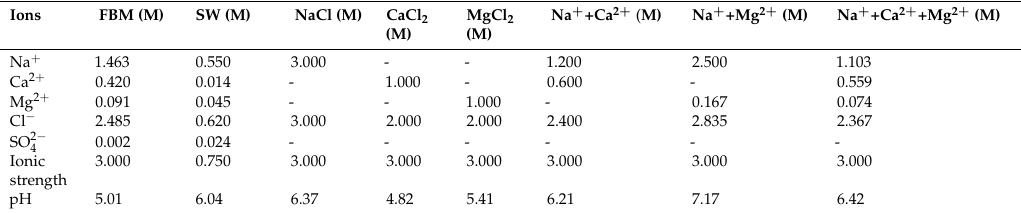
Table 1. Concentration of stock solutions of different brine components